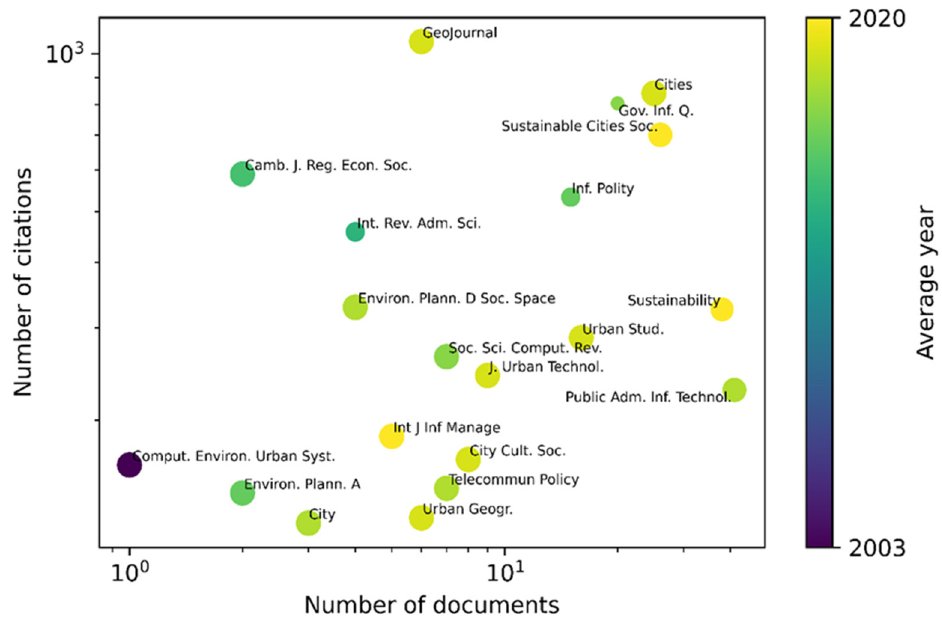
Figure 4. Most relevant sources by number of documents and citations in SPG research (1999–2021).